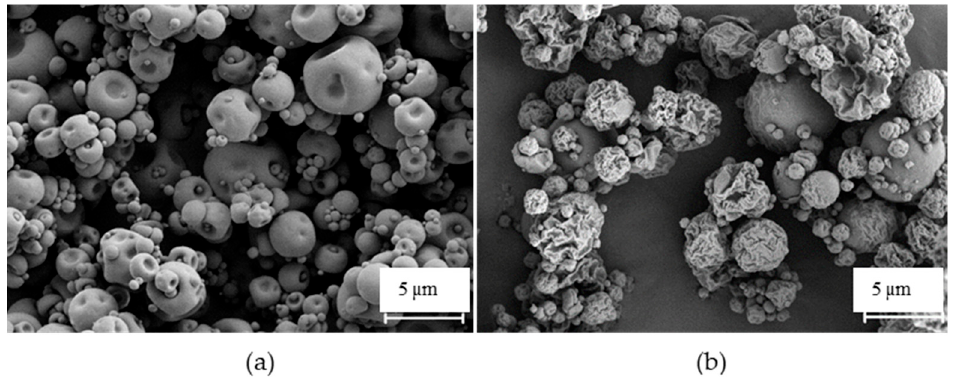
Figure 2. Scanning electron microphotographs of FUC-based microparticles: ( a ) unloaded microparticles and ( b ) FUC/INH/RFB microparticles. FUC: fucoidan, INH: isoniazid, RFB: rifabutin.